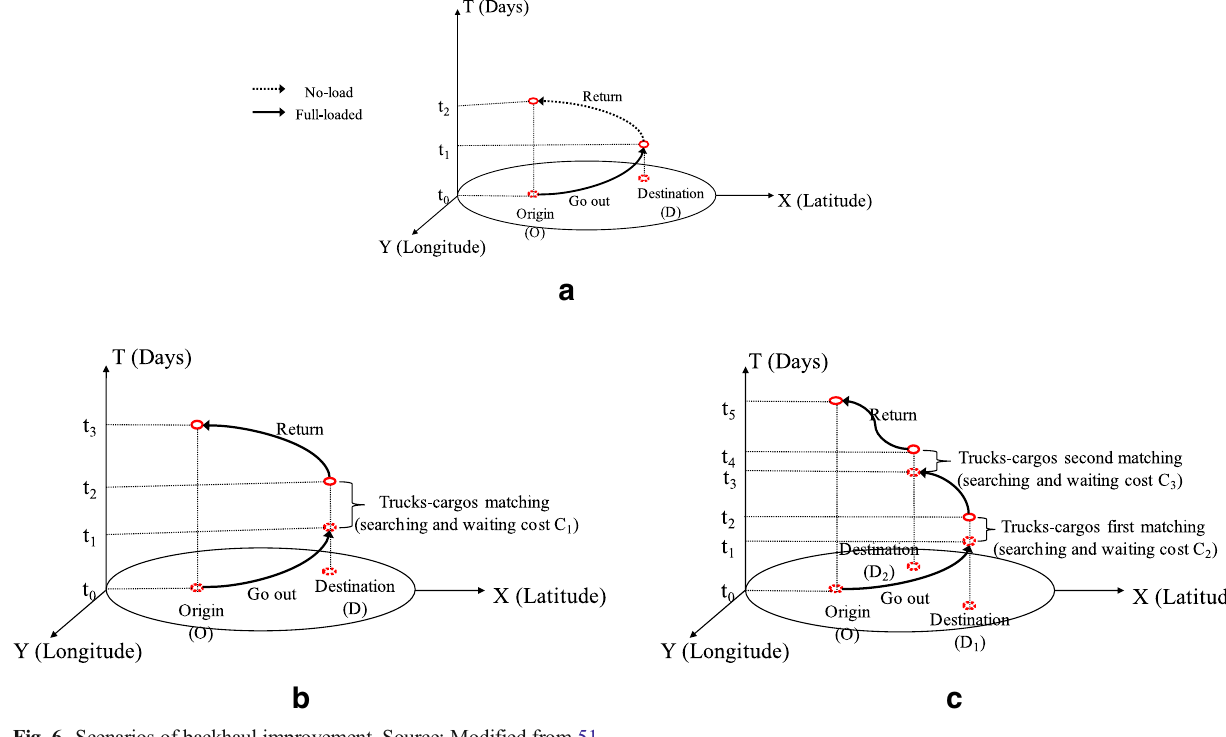
Fig. 6 Scenarios of backhaul improvement. Source: Modified from